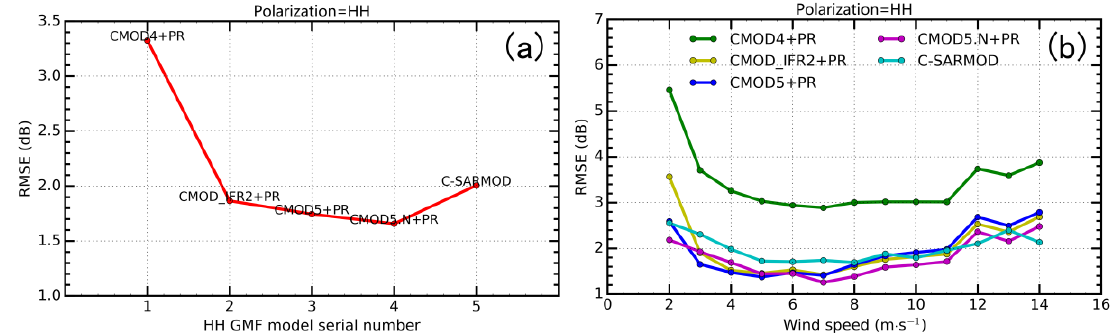
Figure 9. Same as Figure 6, but for HH polarization. The used PR model was developed using GF-3